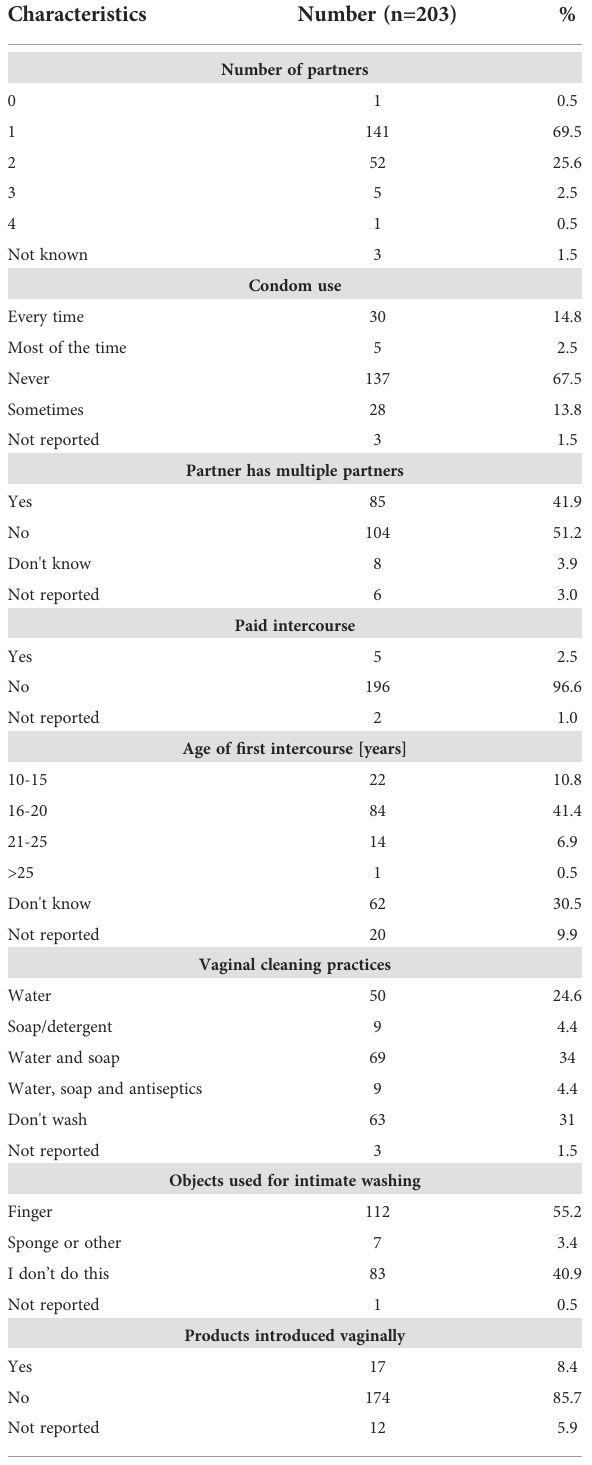
TABLE 2 Sexual and vaginal hygiene practices of enrolled women.